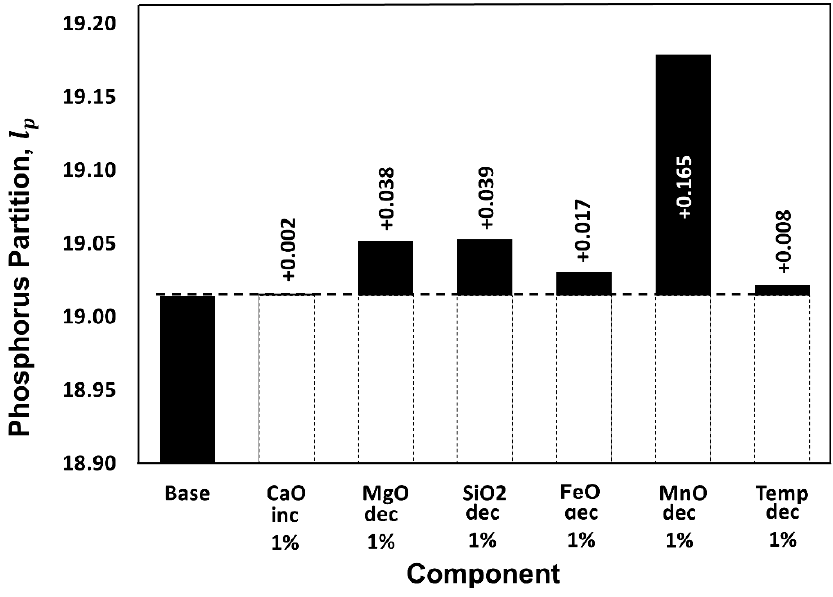
Figure 9. A waterfall analysis of the components in predicting phosphorus partition for plant II.